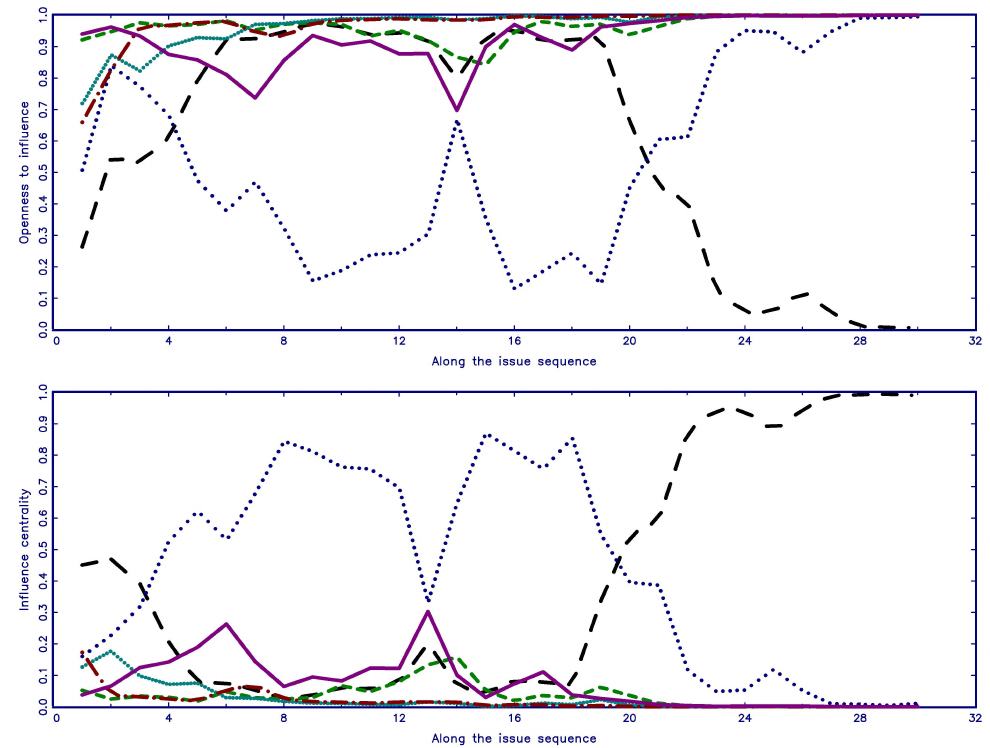
Figure 3: Illustration of the predicted evolution in a n = 6 group with the same initial conditions of the Figure 1 group. The group’s strongly connected configuration of relative interpersonal interpersonal influences and the values of allocated influences on it are both randomly disturbed along the issue sequence on each issue s = 2, 3, . . .